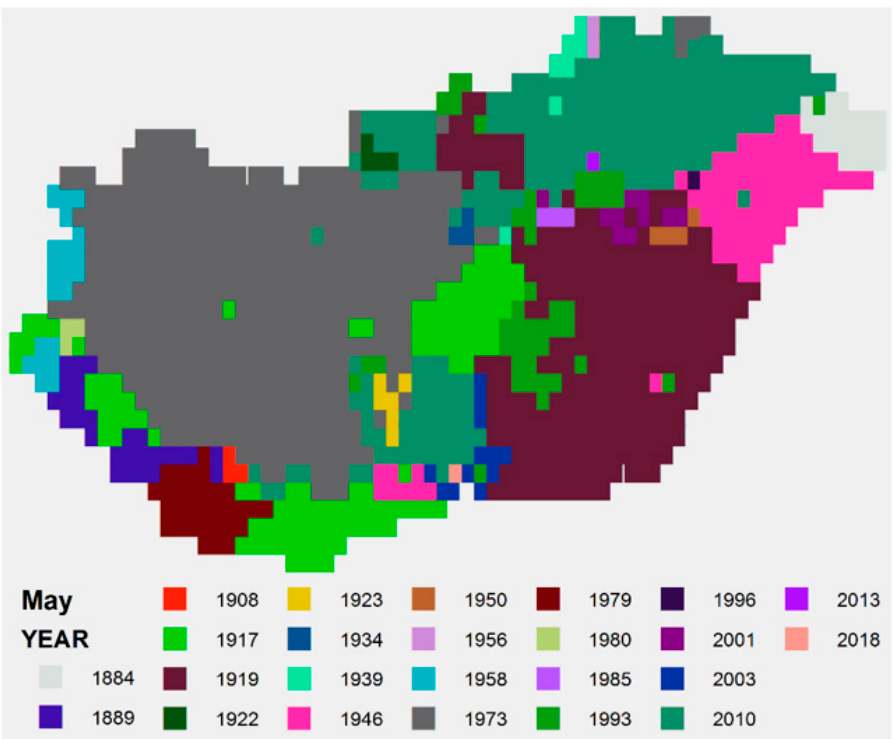
Figure A7. May: Year of maximum SPTI values, 1871–2020.